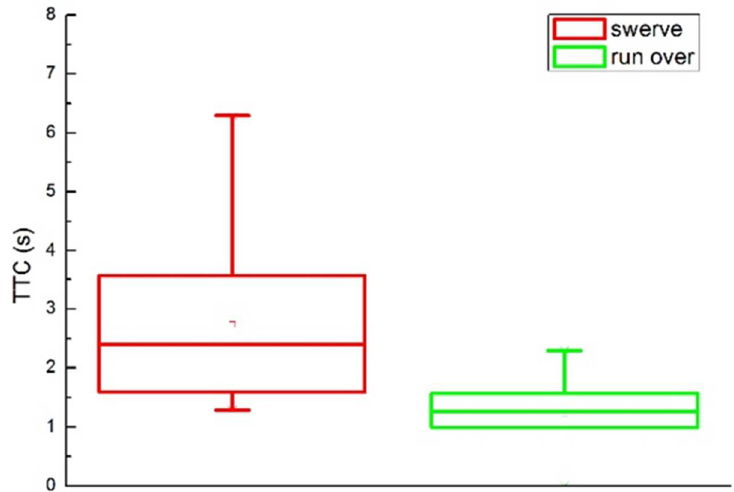
Figure 4. TTC comparison chart from when the driver starts to control the car. The upper and lower quartiles, median, etc., of the time remaining to the collision,